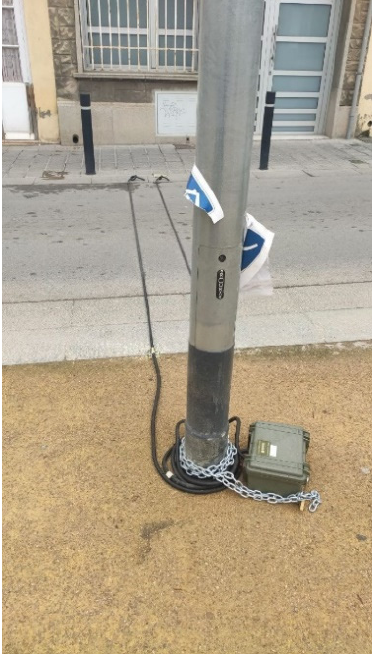
Figure 8. Circulation counting mechanical sensor (photo by author) located at M2 according to Fig- ure 6.